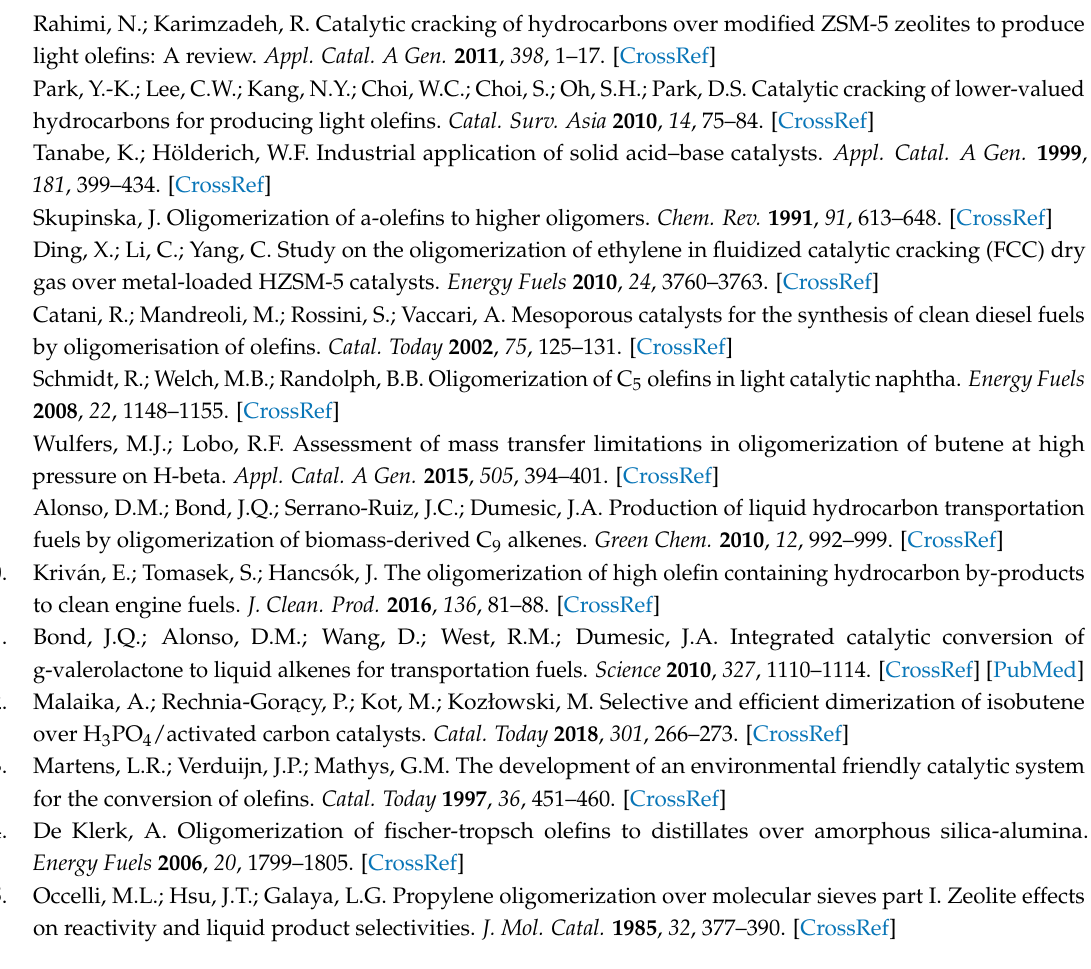
Figure S1: Major reaction mechanism for oligomerization of buten, Figure S2: Conversion and C 8+ selectivity of catalytic oligomerization of HZ5 catalyst and modified catalysts. Reaction condition: temperature 473 K, pressure 1.5 MPa, time 2